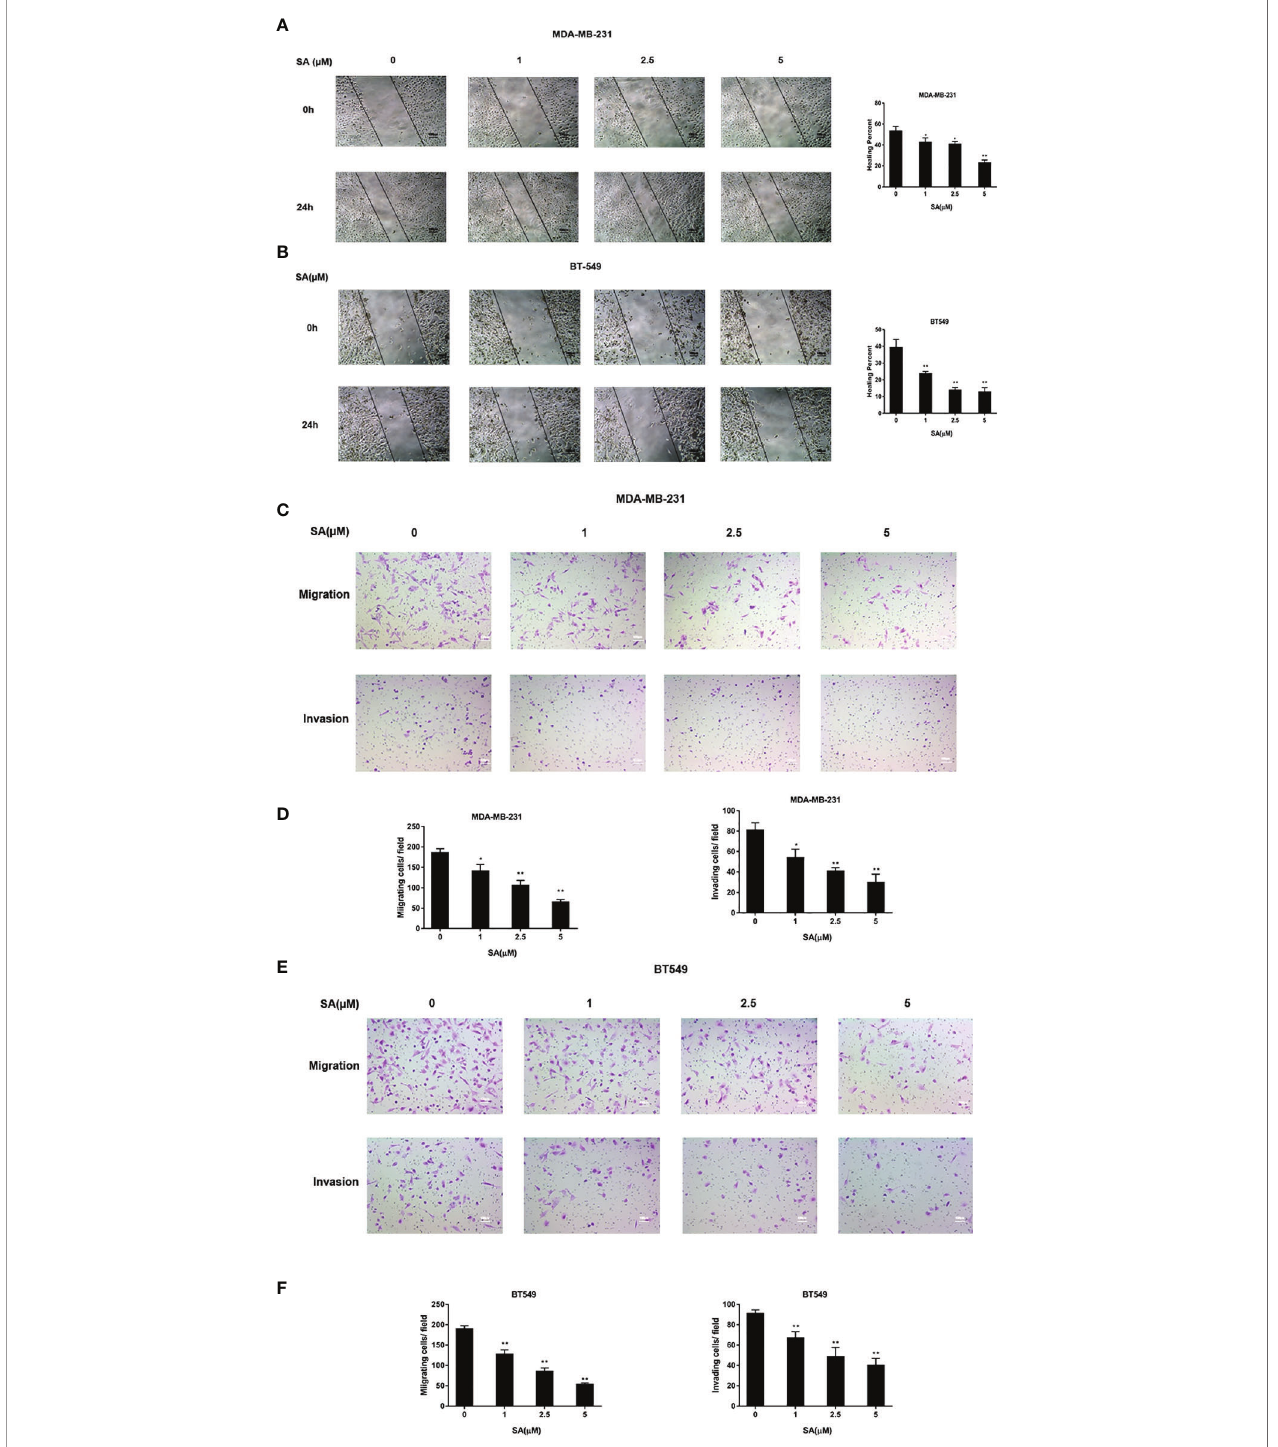
FIGURE 3 | SA attenuates the migratory and invasive abilities of TNBC cells. (A) Representative images and percentages of closures of the wound of the wound healing assay in MDA-MB-231 cells after 24h SA treatment. (B) Representative images and percentages of healing percent of wound healing assay in BT549 cells after 24h SA treatment. (C) Representative images of chamber migration and invasion assay in MDA-MB-231. (D) Percentages of migrating and invading in MDA- MB-231 cells after 24h SA treatment (Compared to the control group, * p < 0.05, ** p < 0.01). (E) Representative images of chamber migration and invasion assay in BT549 cells. (F) Percentages of migrating and invading in BT549 cells after 24h SA treatment (Compared to the control group, ** p <